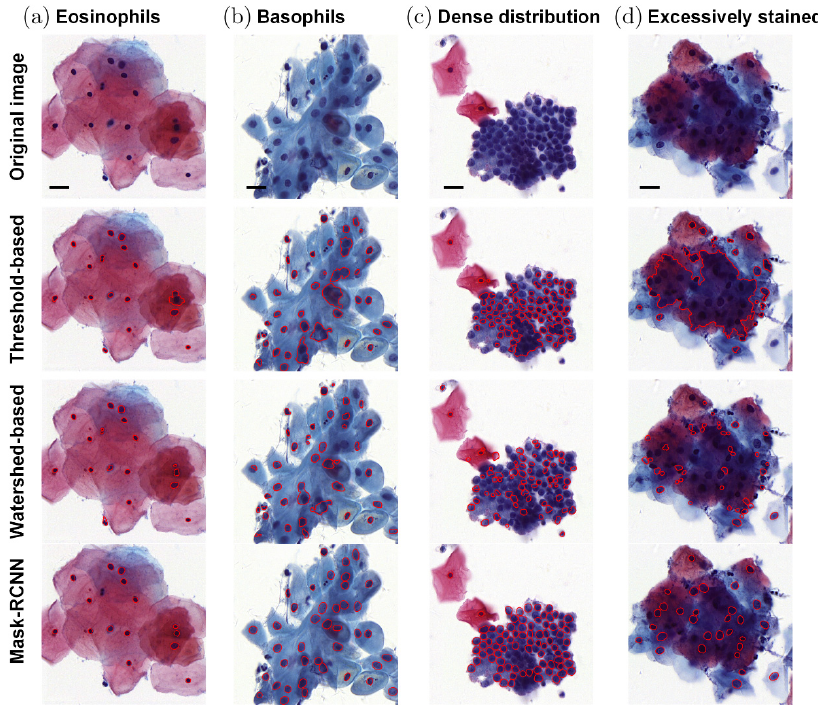
Fig. 3. Segmentation results of typical images obtained by di®erent algorithms. Each column in the illustration showed the performance in the di®erent situations. (a) Eosinophils, (b) basophils, (c) dense distribution, (d) excessively stained. In situation (a) and (b), conventional threshold-based and watershed-based algorithms still has a tolerable performance. However, in complex situation (c) and (d), they seem to be bad choices. Scale bar: 20 (cid:5) m.